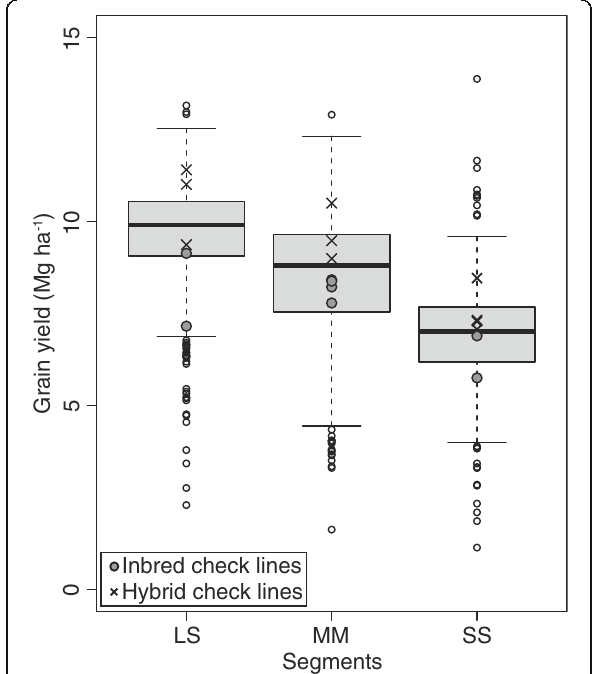
Fig. 1 Best linear unbiased estimations for grain yield performance of hybrids and checks of the market segments LS, MM, and